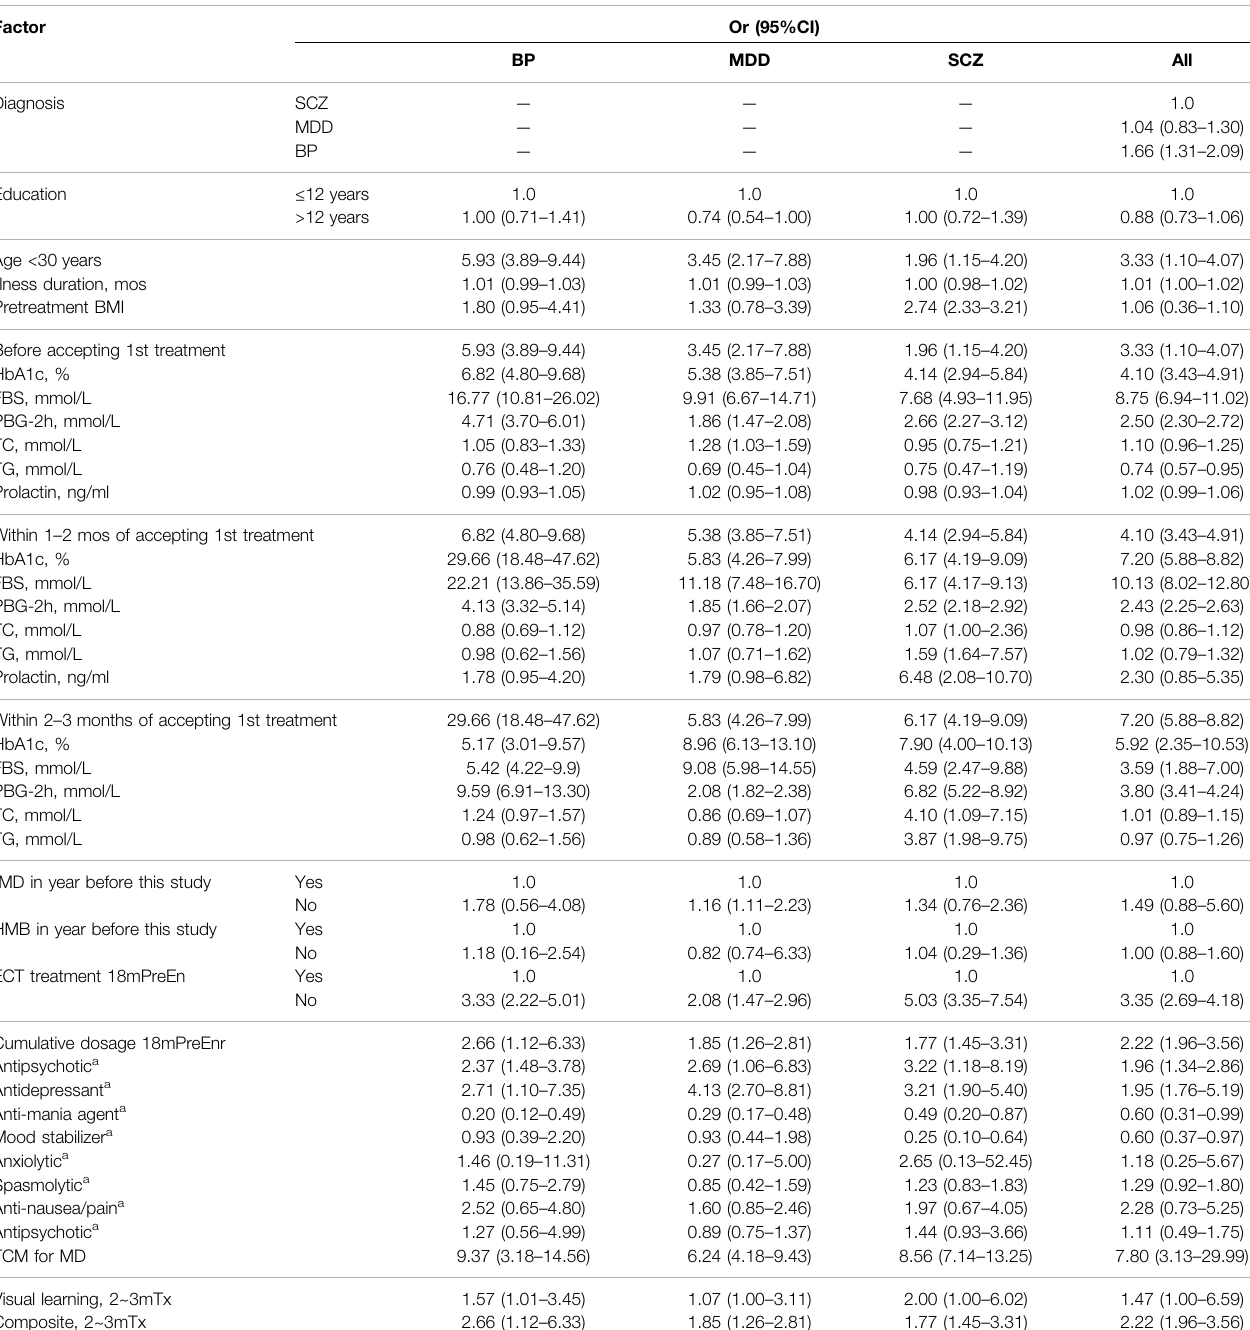
TABLE 4 | Univariate analysis